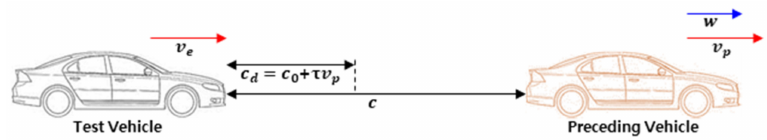
Figure 11. Correlation between test vehicle and preceding